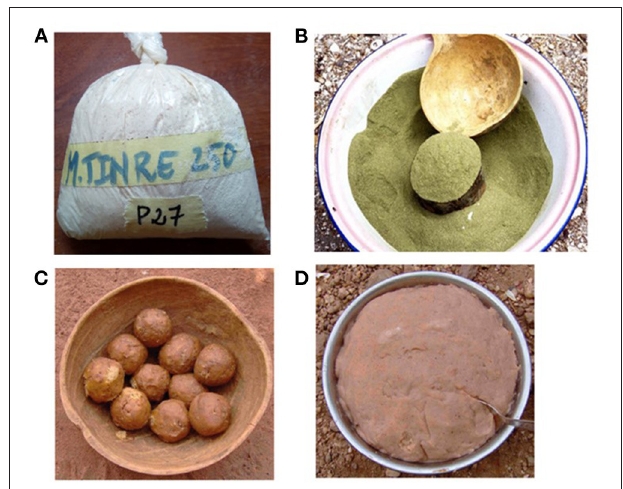
FIGURE 2 | (A–D) Traditionally processed baobab products: pulp powder (A) leaf powder (B) Tayohounta from kernels (C) and Mutchayan from pulp (D) .